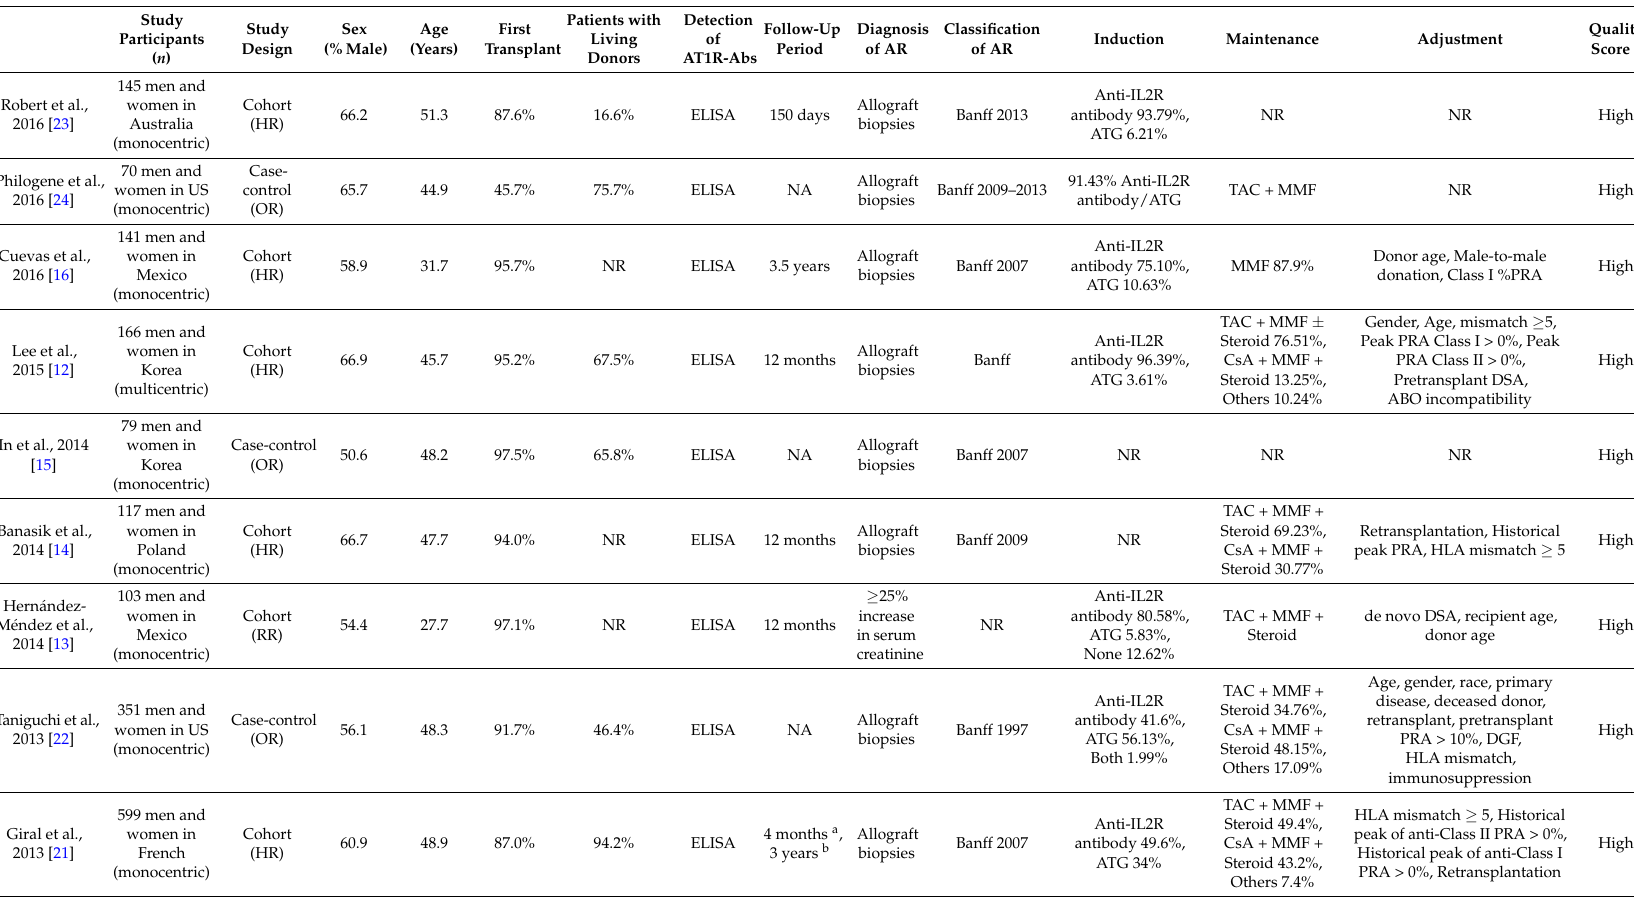
Table 1. Characteristics of studies included in this meta-analysis of anti-angiotensin type 1 receptor antibodies (AT1R-Abs) and kidney allograft outcomes. Study Participants